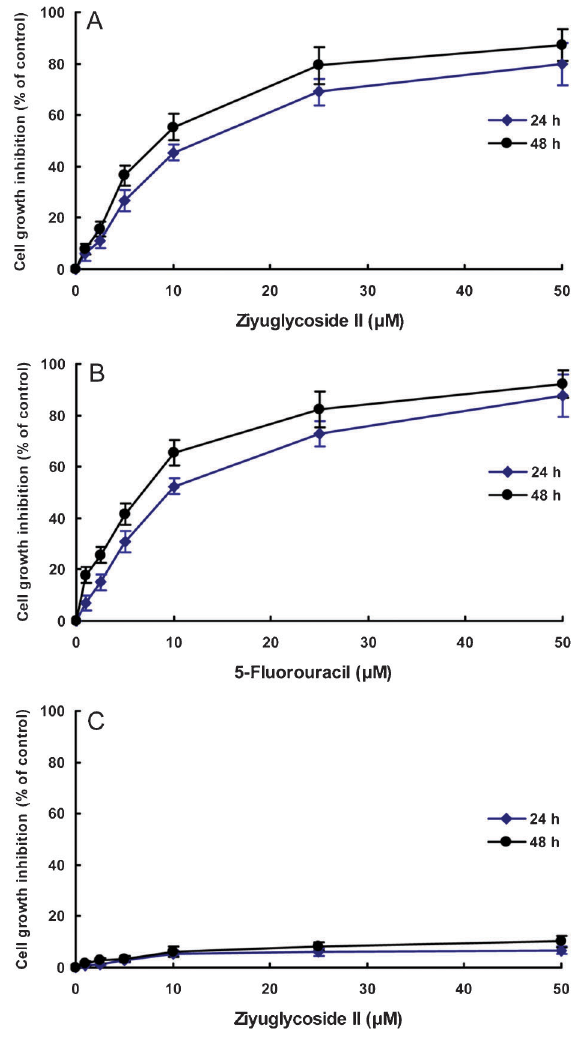
Figure 2. Inhibitory effect of ziyuglycoside II and 5-fluorouracil on the proliferation of BGC-823 or CTLL-2 cells determined by MTT assay. A , Inhibition of BGC-823 cell growth after treatment with ziyuglycoside II. B , Inhibition of BGC-823 cell growth after treatment with 5-fluorouracil. C , Inhibition of CTLL-2 cell growth after treatment with ziyuglycoside II. Data are reported as means±SD percent of cell proliferation relative to the prolifera- tion of controls